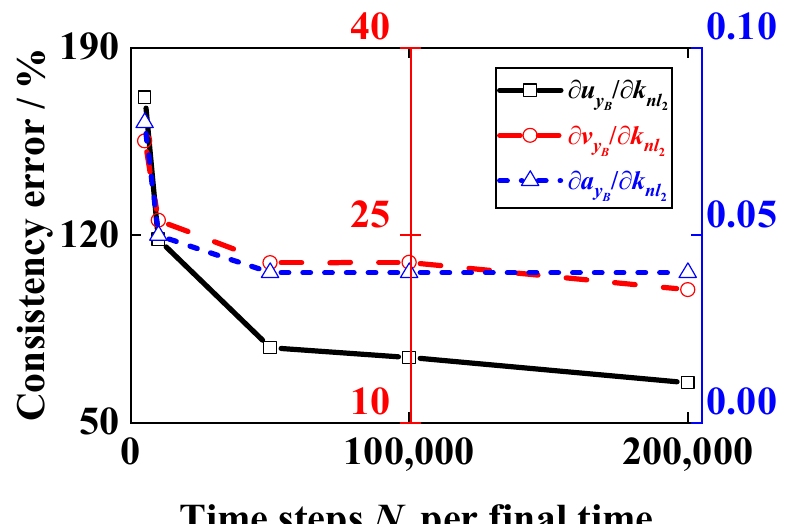
Figure 10. Consistency error between DDM and FDM for response sensitivities at different steps N t.